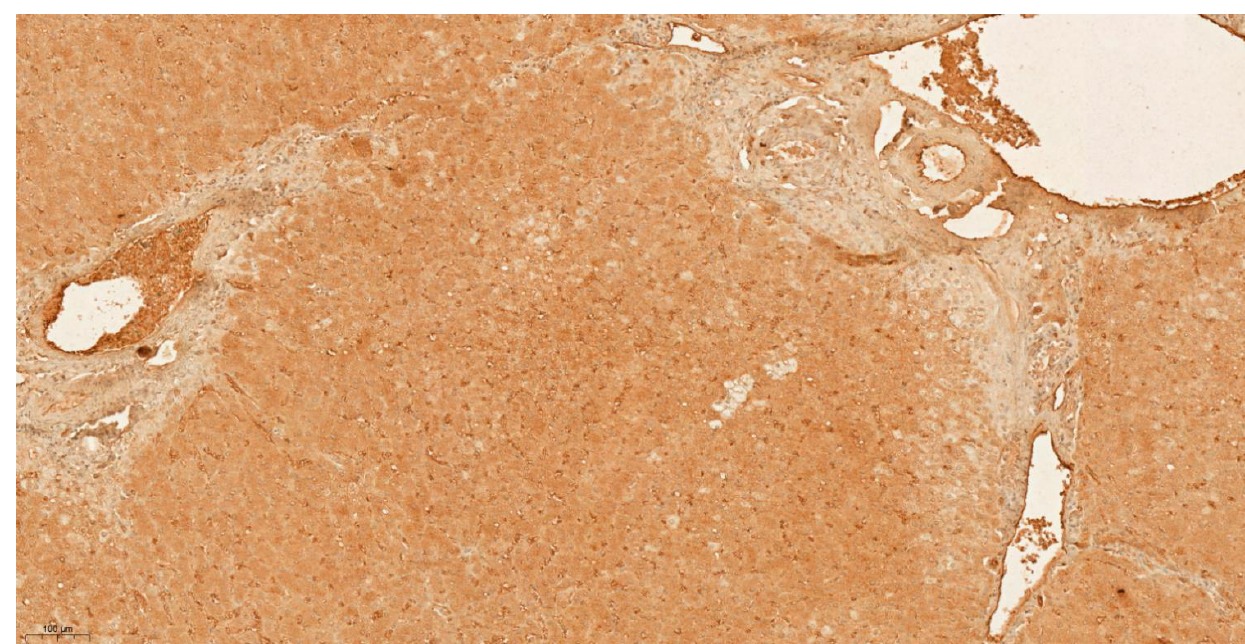
Figure 5. IHC characteristics of kallikrein-6 (KLK6) in normal liver at low power magnification (X10). The brown chromogen indicated protein expression of KLK6 in the nucleus and cytoplasm of the hepatic and stromal cells. The slide shows a section of a normal liver containing normal appearing portal tracts and hepatocytes — demonstrating mild intensity of nuclear and cytoplasmic staining for KLK6 (Allred score 1).